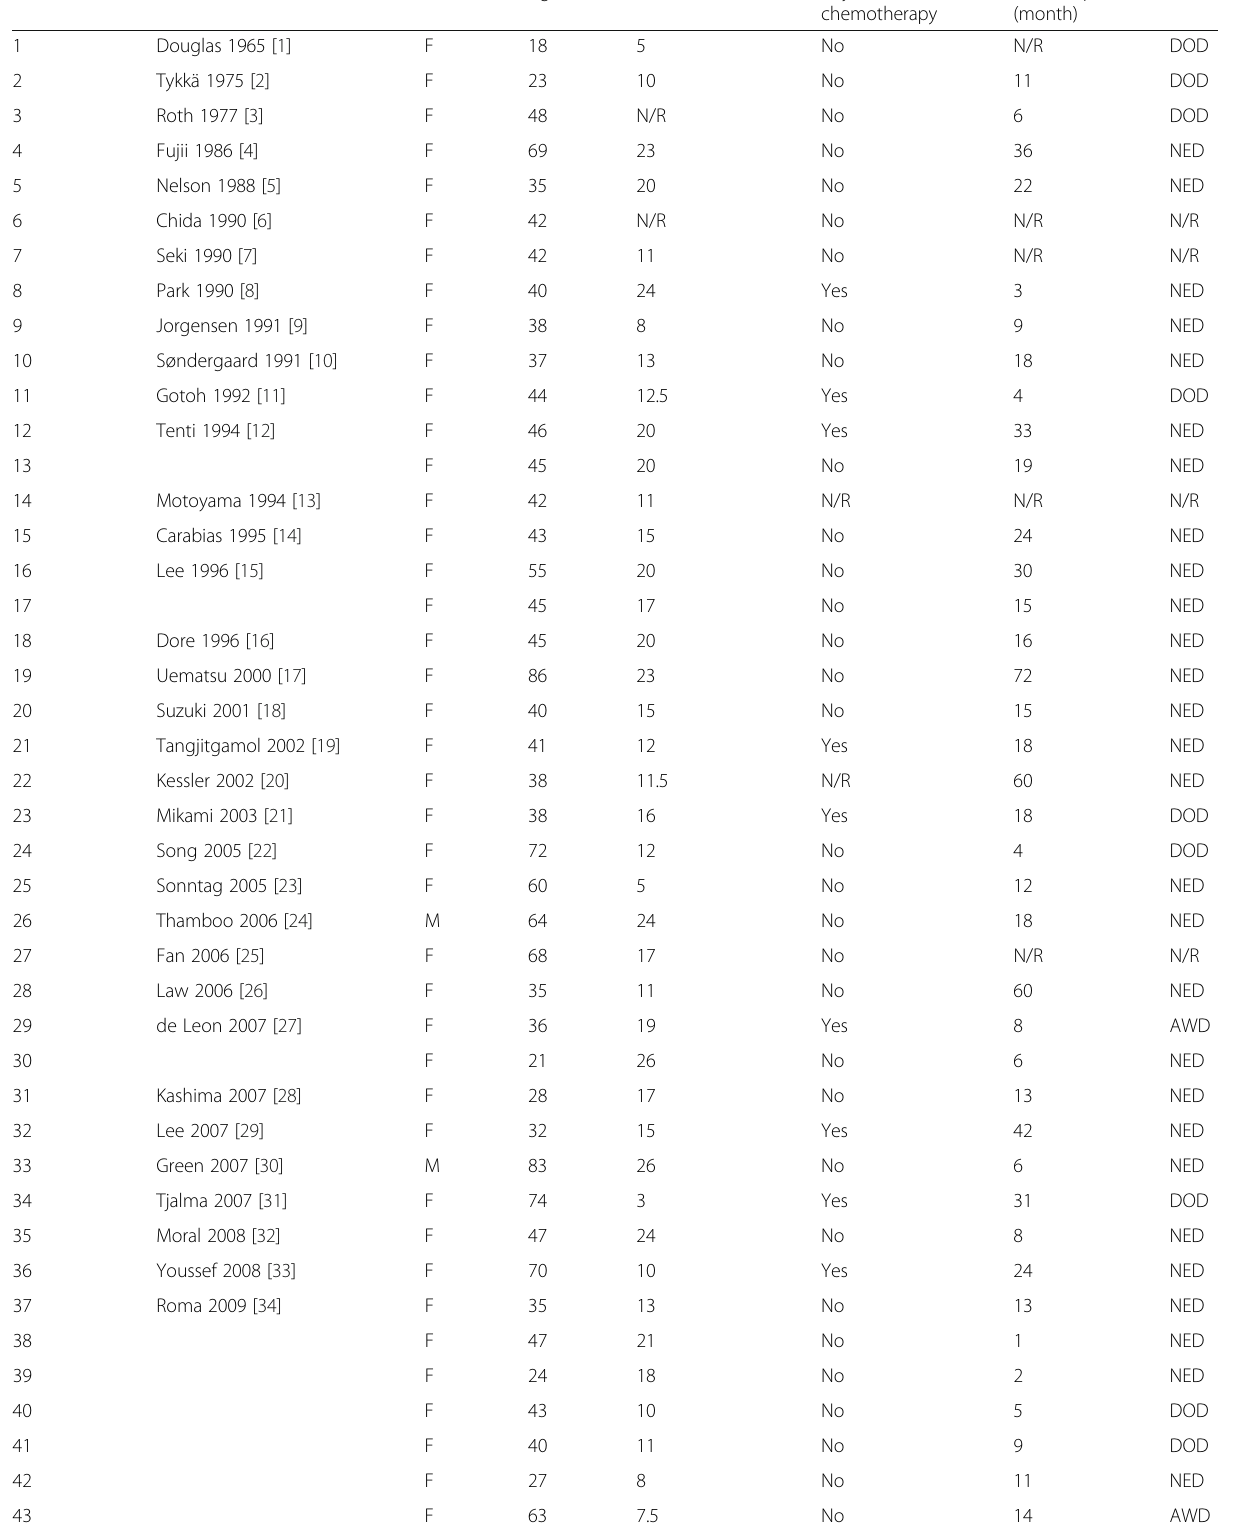
Table 1 Published English studies searched in PubMed Case